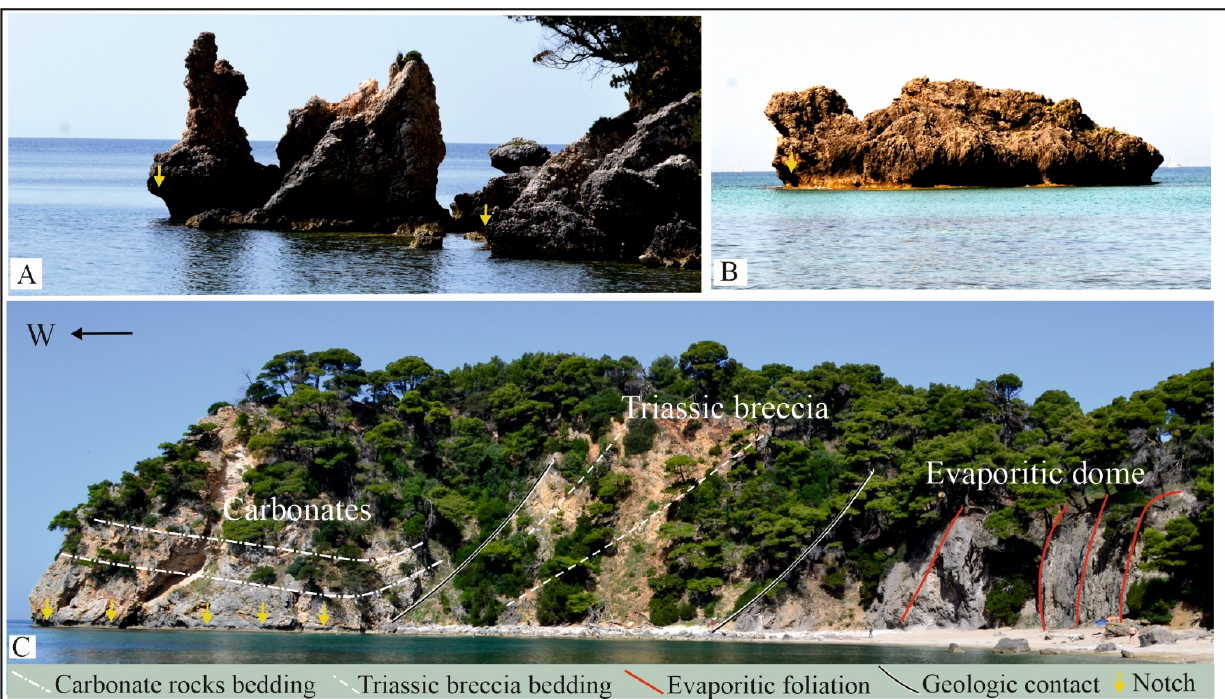
Figure 16. Photo showing the uplift of the coastline in the broader area. The notches in all the photos are higher compared to the present sea level. Yellow arrows show the notches. ( A ) Photo width is 10 m., and is taken looking northwest. ( B ) A small island at the north part of the study area, showing clearly a notch. ( C ) Uplifted wave cut notch in a coast just north of the study area. Remarkable is, in the west end of the outcrop, the wave cut notch in direct proximity with the evaporitic dome. The width of the outcrop is about 150 m and the photo is taken looking north.